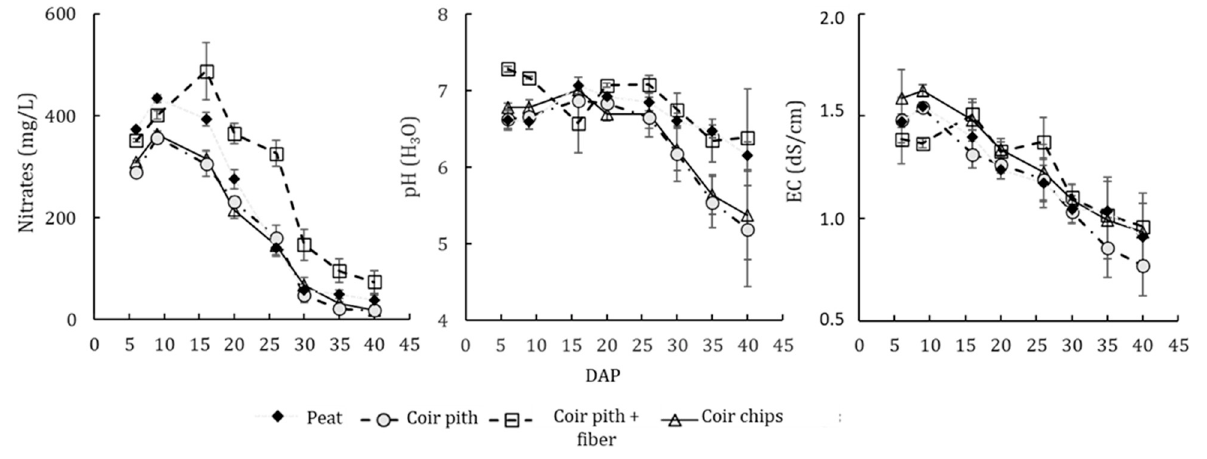
Figure 1. The NO 3 and H 3 O + concentrations and EC in the drainage water. Each symbol represents the mean of five replicates, and the error bars represent ± 1SE.